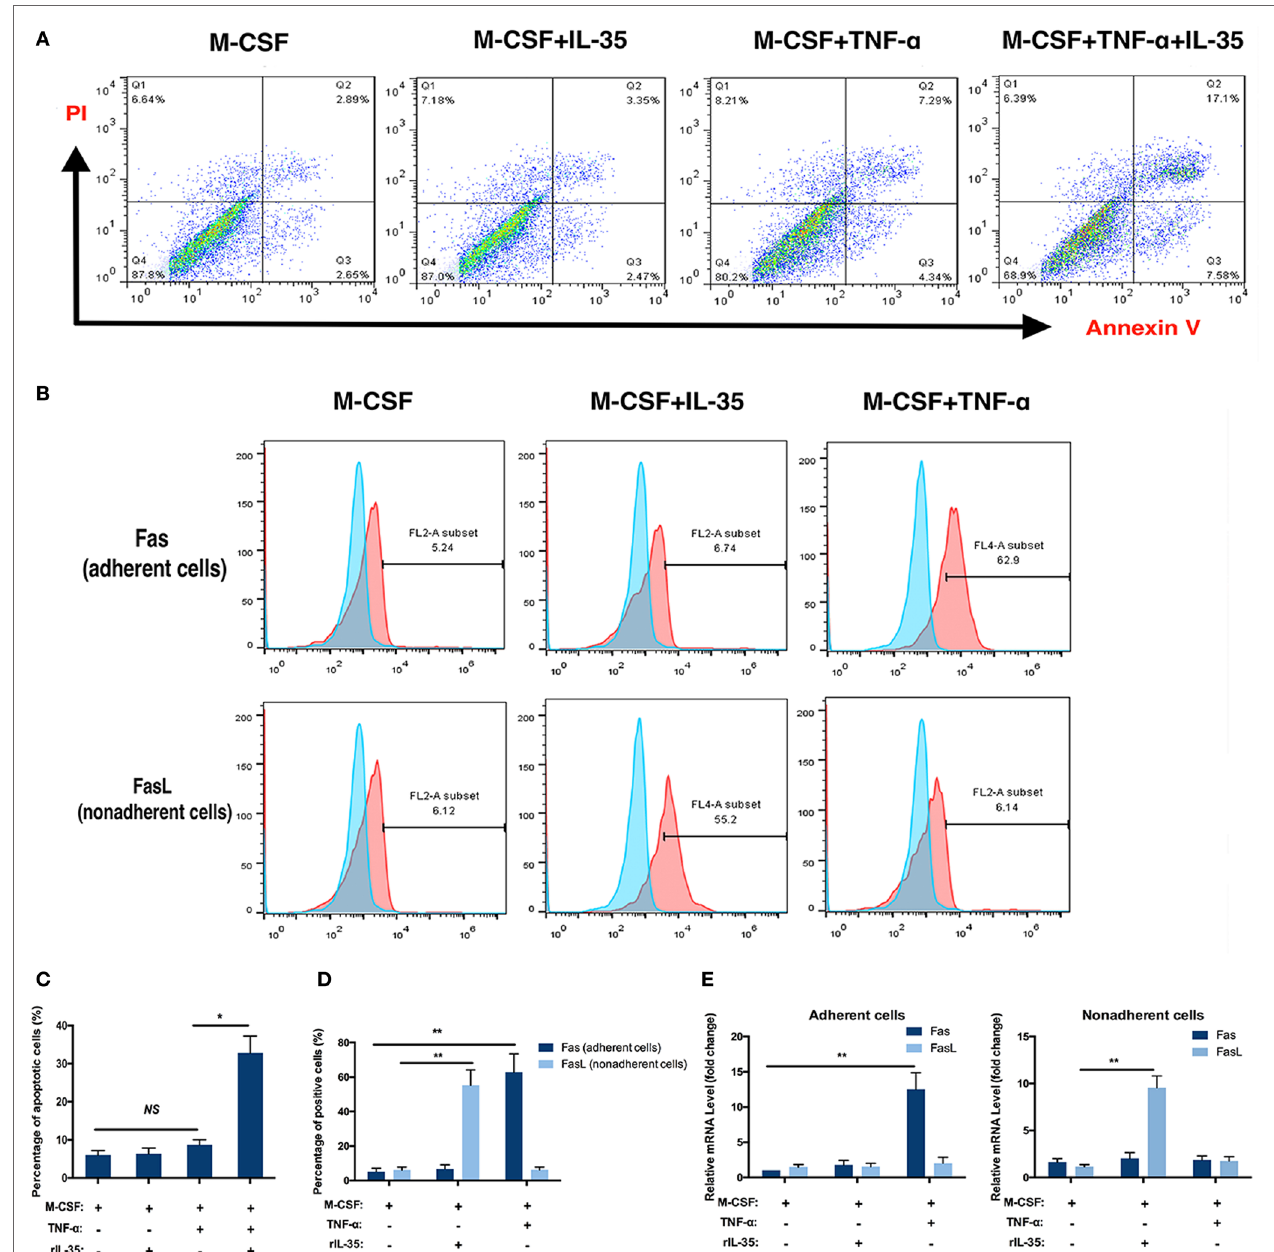
FigUre 3 | Flow cytometry analysis. (a,c) Apoptosis analysis using Annexin V/FITC-PI kit. (B,e) Fas in adherent bone marrow cells and Fas Ligand in non-adherent bone marrow cells were detected by flow cytometry. (D) mRNA of Fas and Fas Ligand were detected in different groups. * p < 0.05, ** p <